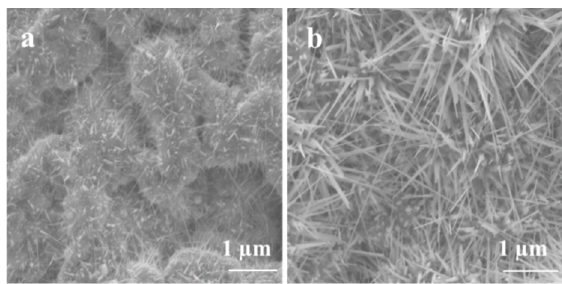
Figure 9. The effect of the oxidation temperature on the growth of Ga 2 O 3 in the presence of 300 nm Ag catalyst. ( a ) 800 °C. ( b ) 1000 °C.